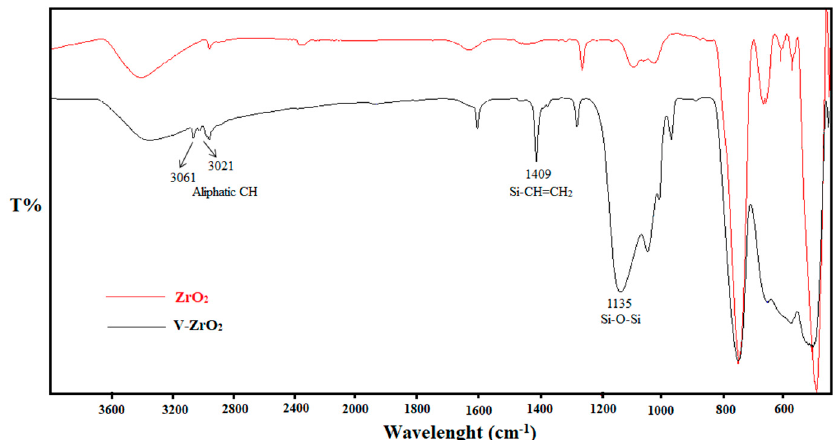
Figure 1. FTIR spectra of ZrO 2 and V-ZrO 2 [27].